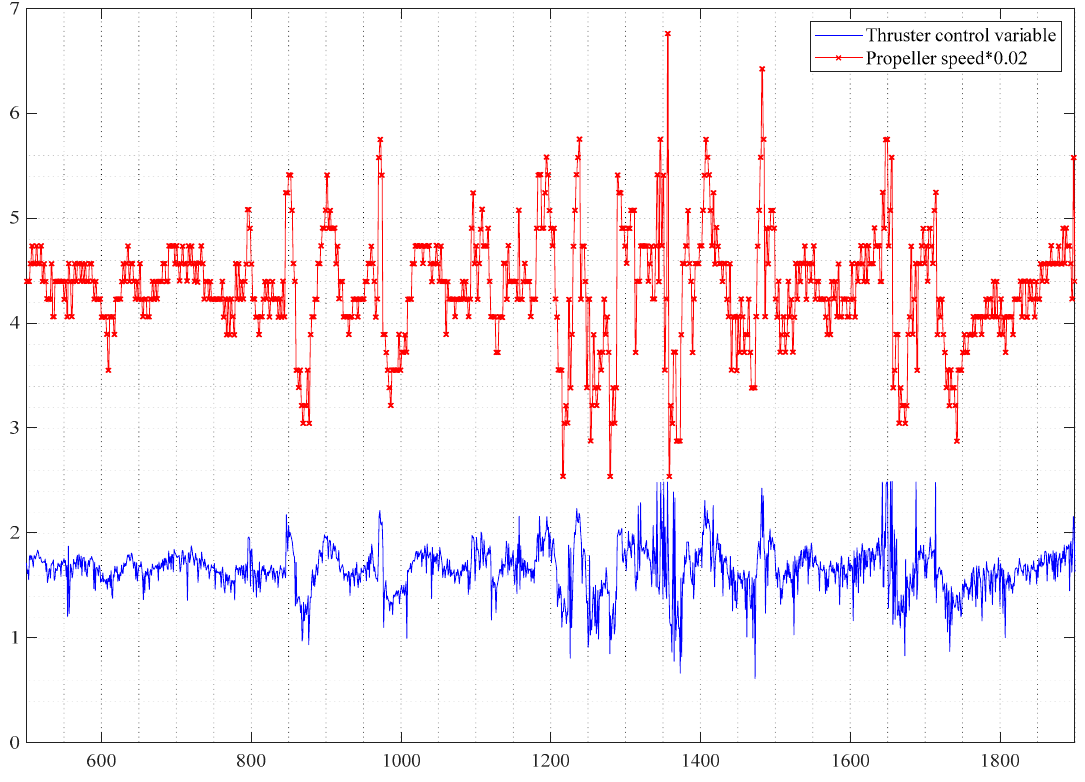
Figure 8. Thruster control variable and propeller speed during sea trial of the